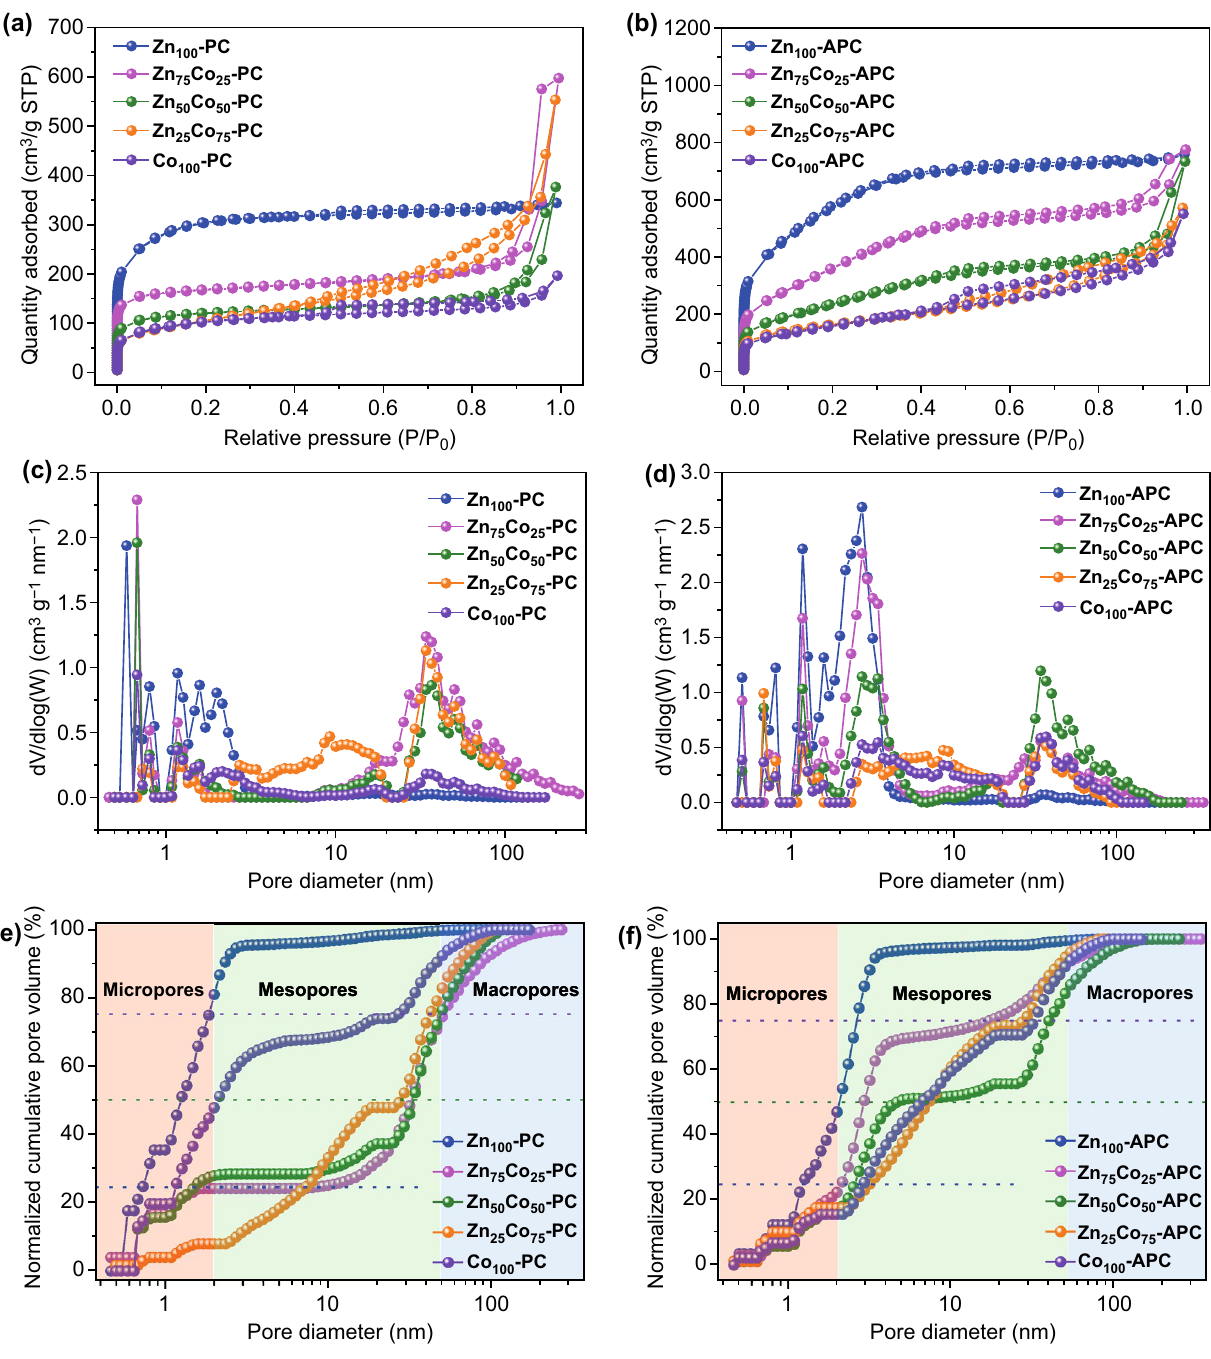
Fig. 2 a , b N 2 adsorption–desorption isotherms, c , d pore size distribution curves and e , f normalized cumulative pore size distributions of Zn x Co 100− x –PCs and Zn x Co 100− x